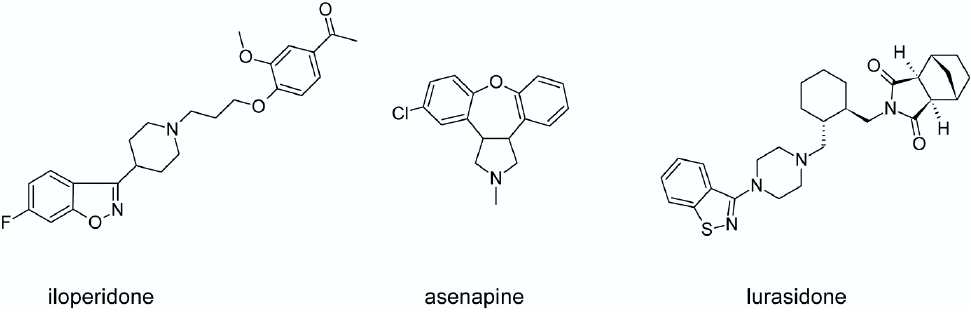
Figure 4. New second generation antipsychotics.